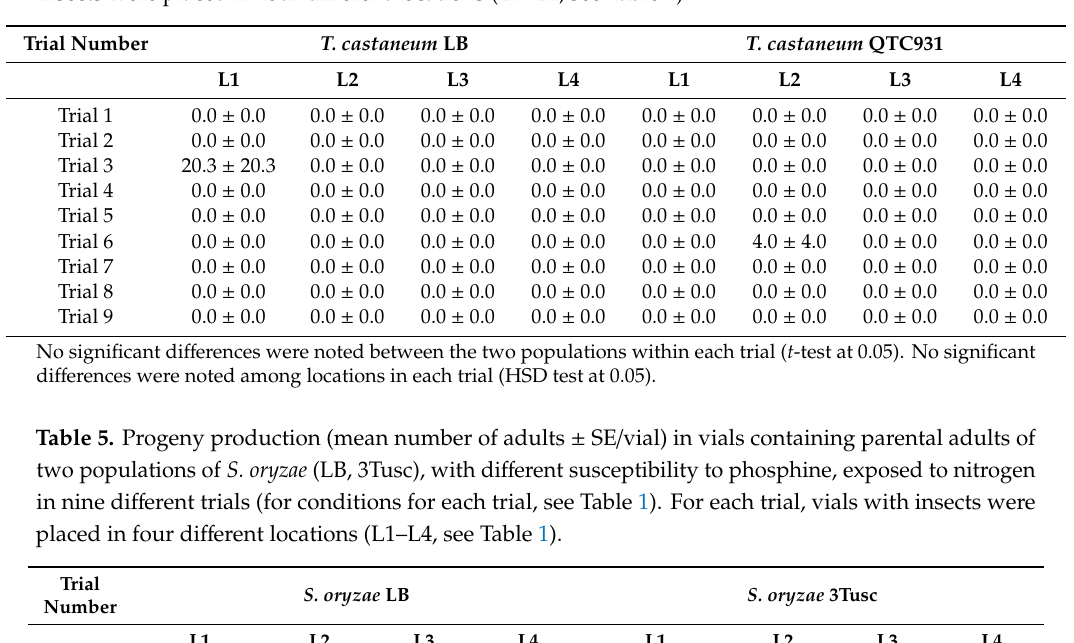
Table 4. Progeny production (mean number of adults ± SE / vial) in vials containing parental adults of two populations of T. castaneum (LB, QTC931), with di ff erent susceptibility to phosphine, exposed to nitrogen in nine di ff erent trials (for conditions for each trial, see Table 1). For each trial, vials with insects were placed in four di ff erent locations (L1–L4, see Table 1).